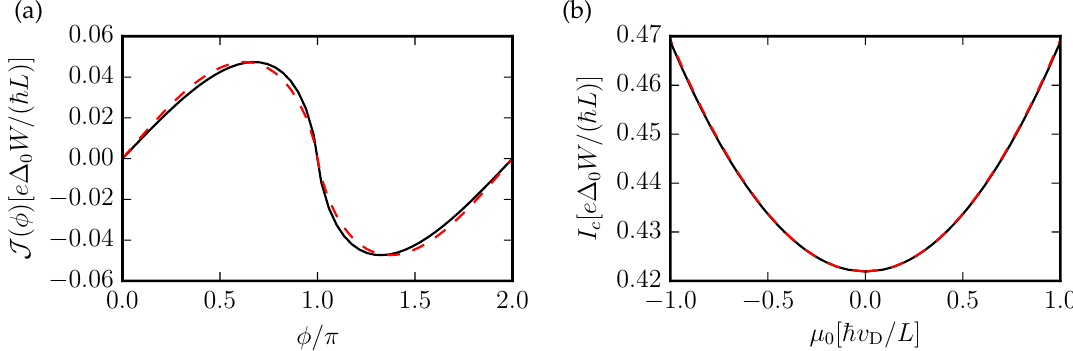
( φ ) defined in Equation (7) (solid black line) and Figure 1. Panel ( a ): J a 0 = 0.112 (dashed red line) in units of e ∆ 0 W / ( ¯ hL ) as a function of the phase φ . Panel ( b ): Critical current, in units of e ∆ 0 W / ( ¯ hL ) , at low doping as a function of the Fermi level at zero temperature. The solid black line refers to the critical current obtained by maximing expression in Equation (6), the dashed red line is the approximation of the critical current given by Equation